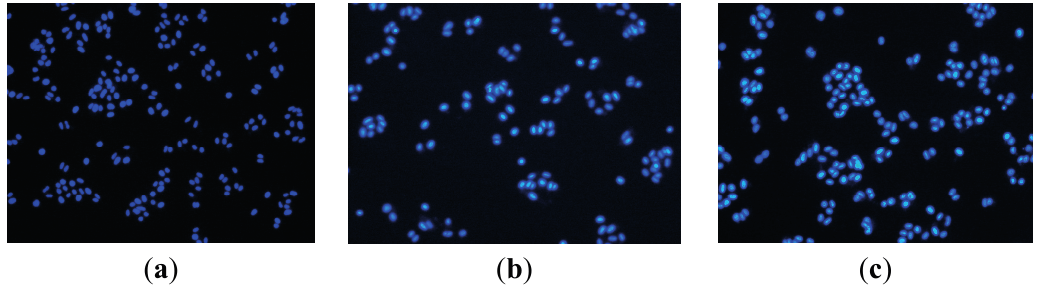
Figure 2. Hoechst 33,258 staining of compound 9n in HeLa cells. ( a ) Cells not treated